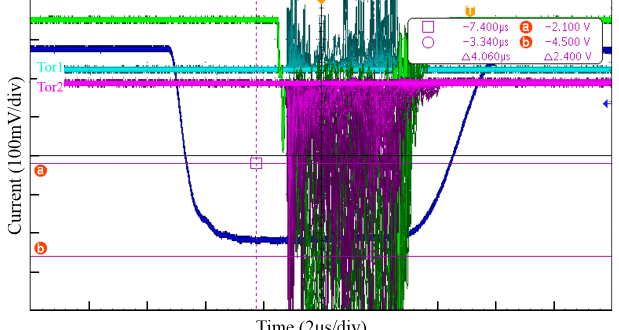
FIG. 5. Record of a serious discharge event. Tor1: readout of the FCT1; Tor2: readout of the FCT2. All channels are set to reverse phase mode. The unit of the ordinate only applies for the Tor1 and Tor2